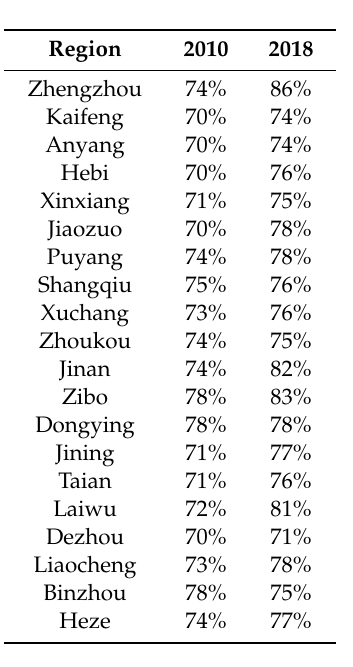
Table 3. Proportion of built-up land carbon emissions in prefecture-level cities of the lower Yellow River area in 2010 and